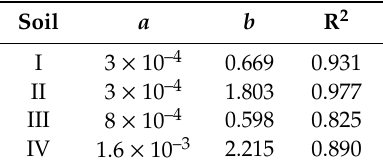
Table 5. Parameters a and b of the scaling laws (11) for each porous medium configurations and relative values of R 2